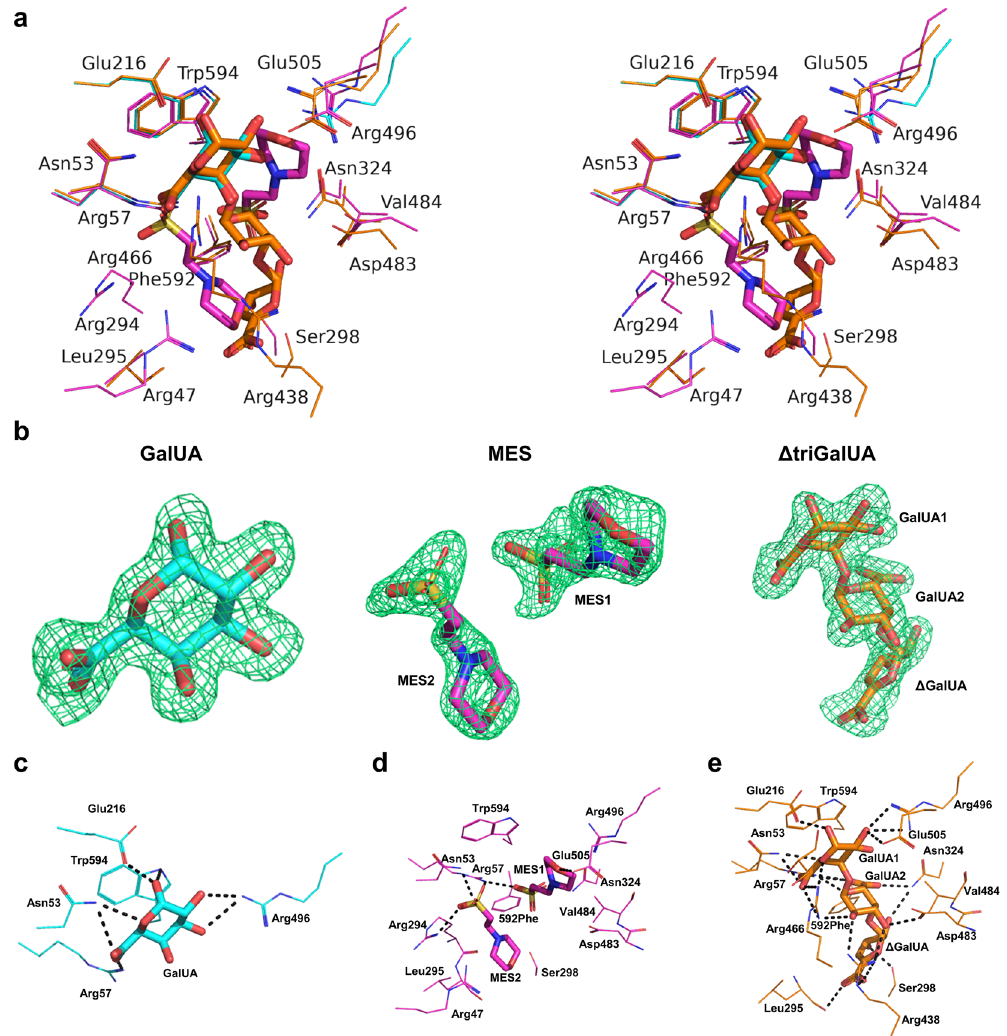
Figure 4. Interactions between SPH1118 and the ligands. Red, blue, and yellow represent oxygen, nitrogen, and sulfur atoms, respectively in ( a – e ). ( a ) Residues interacting with GalUA, MES, and ΔtriGalUA via hydrogen bonds and C–C contacts shown in stereo view. Line models show the side chains of the residues interacting with each ligand. Stick models show each ligand (GalUA, MES, and ΔtriGalUA). Cyan, SPH1118/GalUA; magenta, SPH1118/2 × MES; orange, SPH1118/ΔtriGalUA. ( b ) Omit maps of GalUA, MES, and ΔtriGalUA. Electron density maps ( F o – F c ) of each ligand are shown in green mesh contoured with 3.0 σ. ( c ) Residues interacting with GalUA. Dotted lines represent hydrogen bonds. Cyan represents carbon atom. ( d ) Residues interacting with MES. Dotted lines represent hydrogen bonds. Magenta represents carbon atom. ( e ) Residues interacting with ΔtriGalUA. Dotted lines represent hydrogen bonds. Orange represents carbon